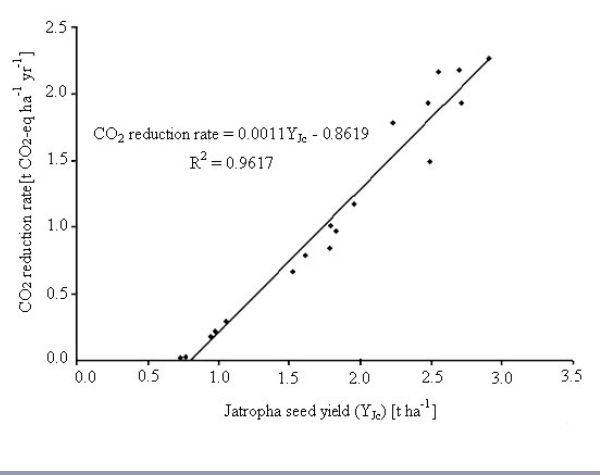
Fig. 2. Regression analysis of the life-cycle CO rate in function of Jatropha seed yields (based on Achten